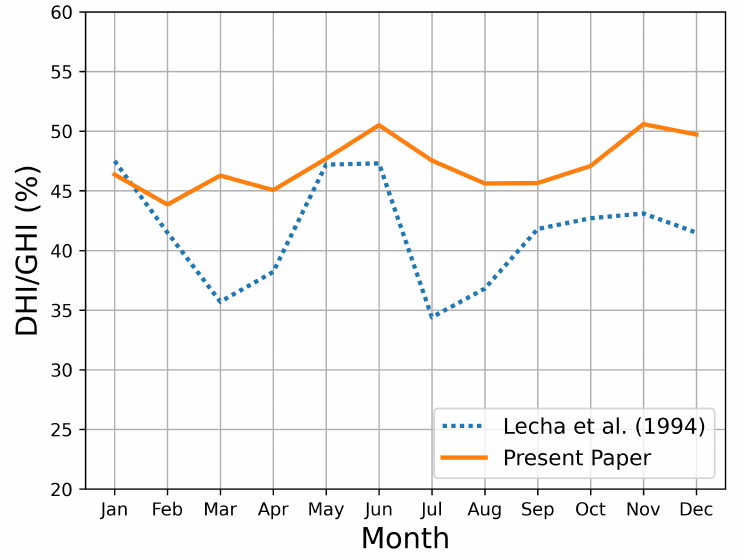
Figure 5. Ratio between the monthly averages of diffuse (DHI) and global (GHI) horizontal surface solar irradiances for the entire period of measurements. Values from Lecha et al. [31] are included (blue dot